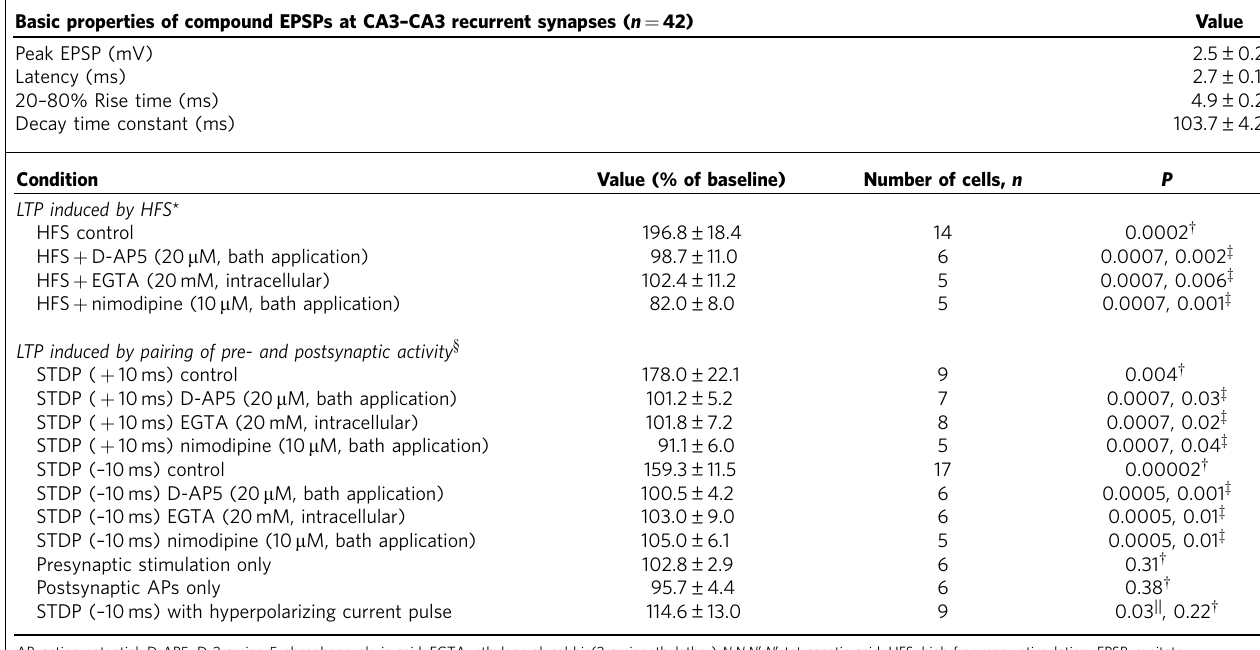
Table 1 | Synaptic plasticity at CA3–CA3 recurrent